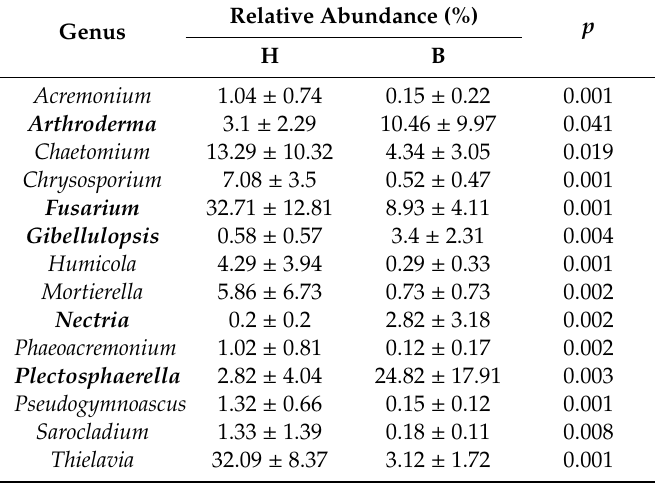
Table 1. Genus-level indicator taxa of the fungal communities in healthy (H) and bacterial wilt-diseased (D) tomato plant rhizospheres.